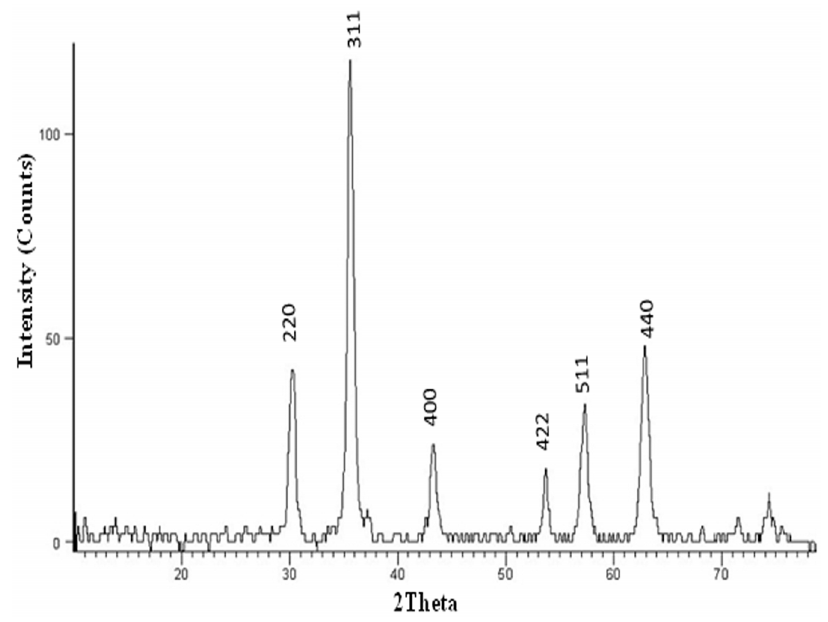
Figure 3. Graph represents the XRD pattern of synthesized MNPs shows the formation of Fe 3 O 4 based on the comparison of their XRD patterns with the standard pattern of Fe 3 O 4 (04-013-9808). The diffraction peaks are quite identical to characteristic peaks of the Fe 3 O 4 crystal with the cubic spinal structure.